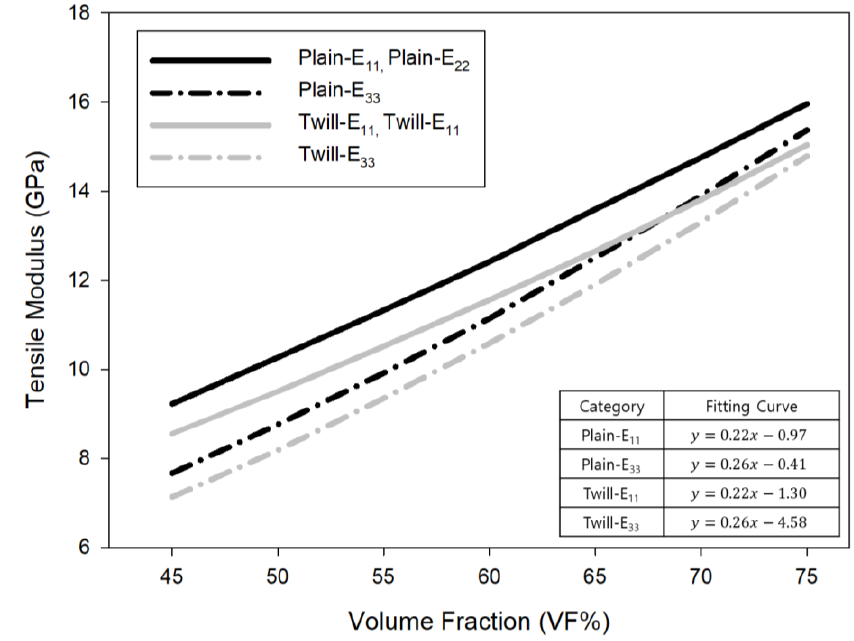
Figure 3. Comparison of the predicted values of elastic modulus.